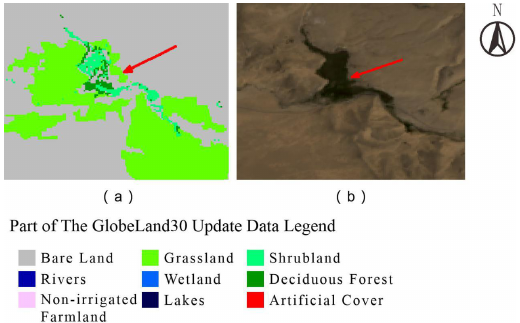
Figure 7. Rivers are missing updated （ a ） GlobeLand30 update data （ b ） The image used for data updating 4.1.3